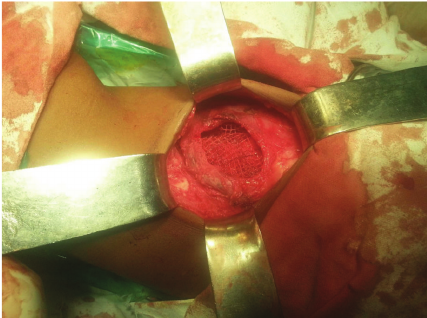
Figure 6: A prosthetic mesh placed between the inverted sac and the muscular layer.